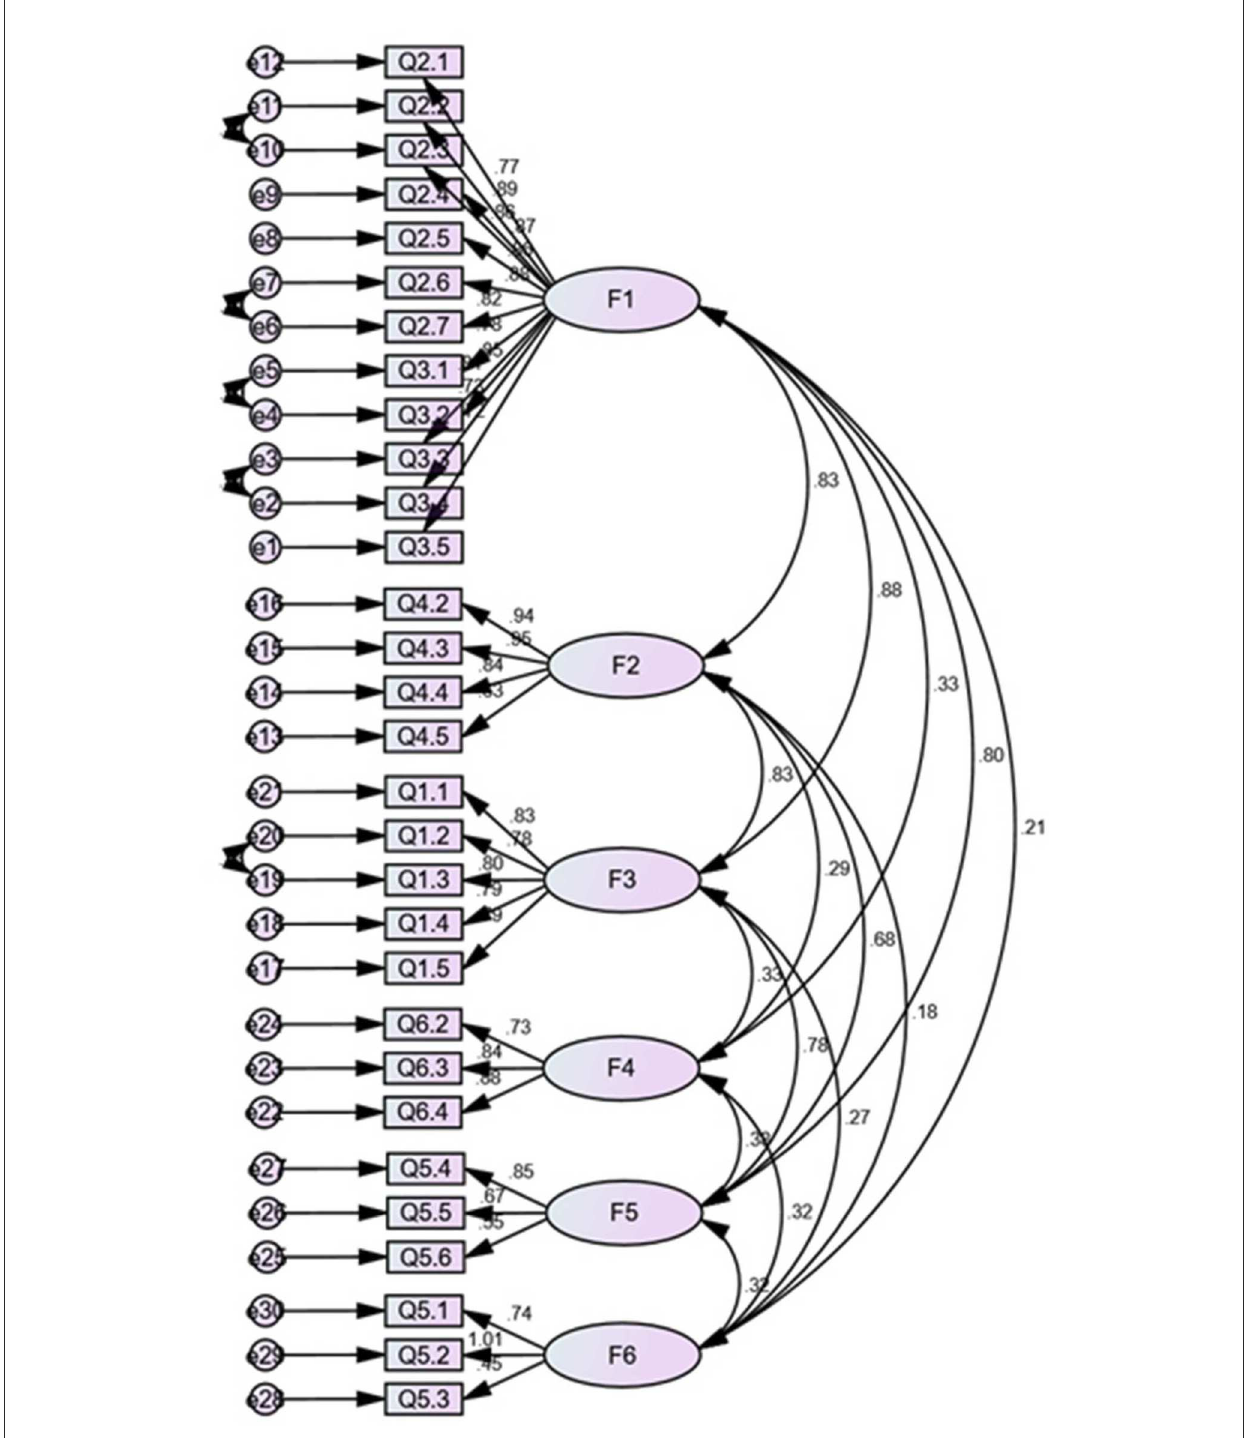
FIGURE2 Structural validity of confirmatory factor